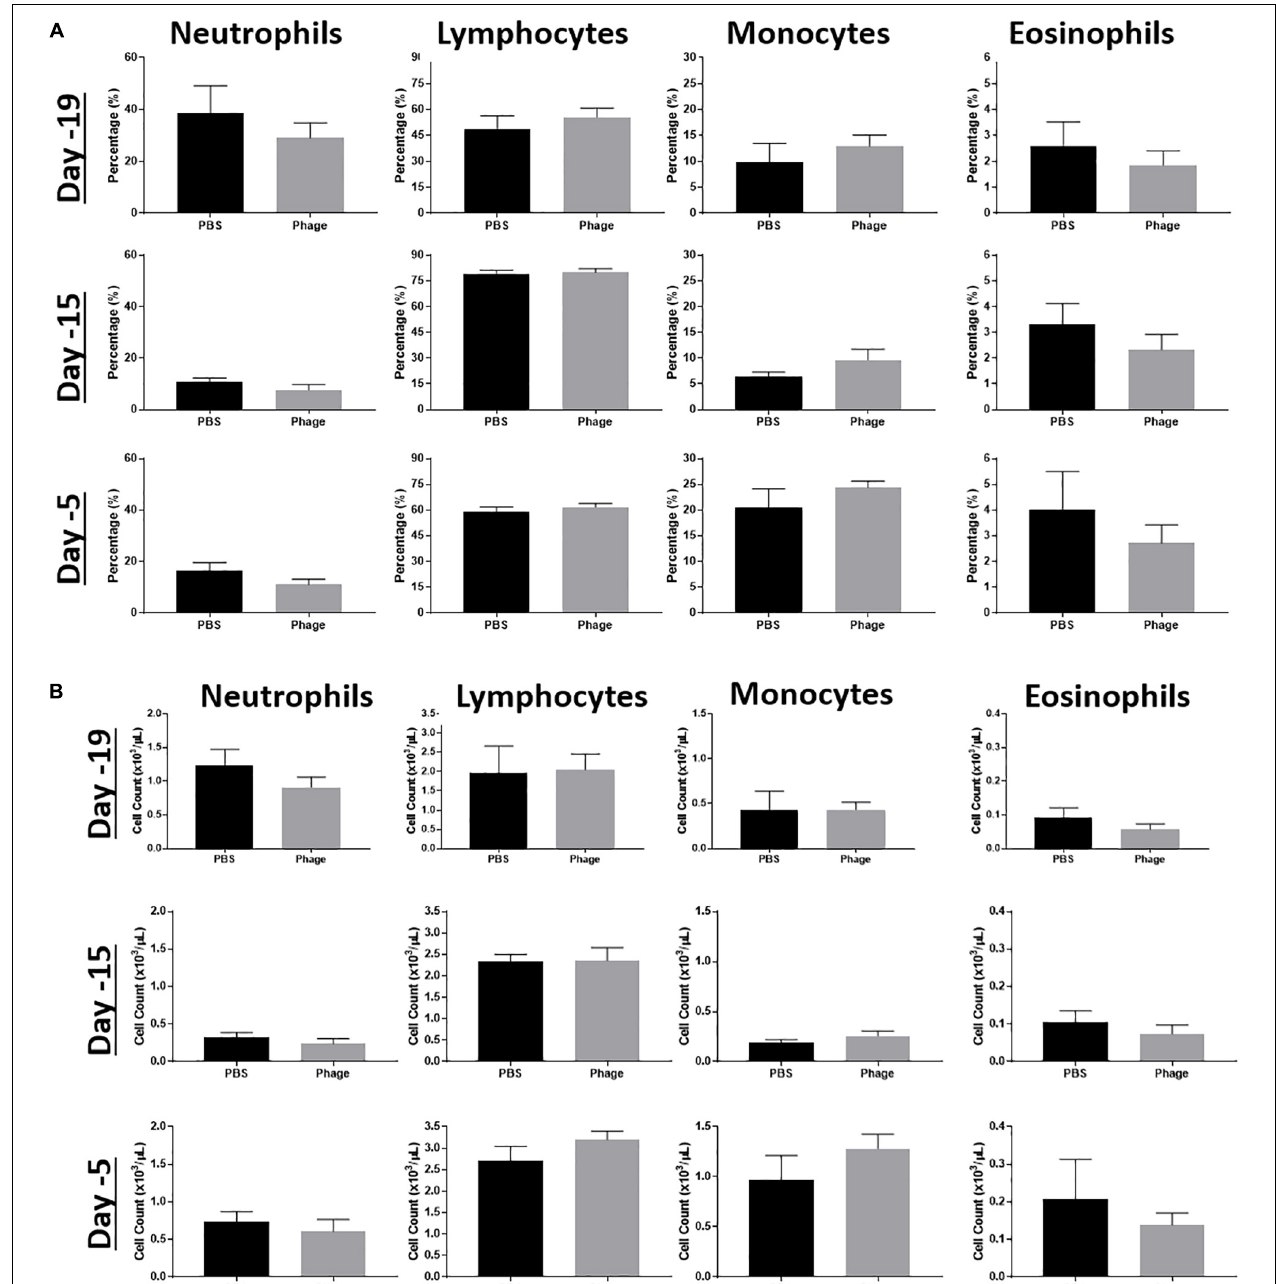
FIGURE 4 | Effects of phage mixture on peripheral immune cell populations. Complete blood counts, (A) percentages and (B) cell count were measured from whole blood at various time points following PBS (control) or phage mixture administration in naïve mice. N = 6 per group per time